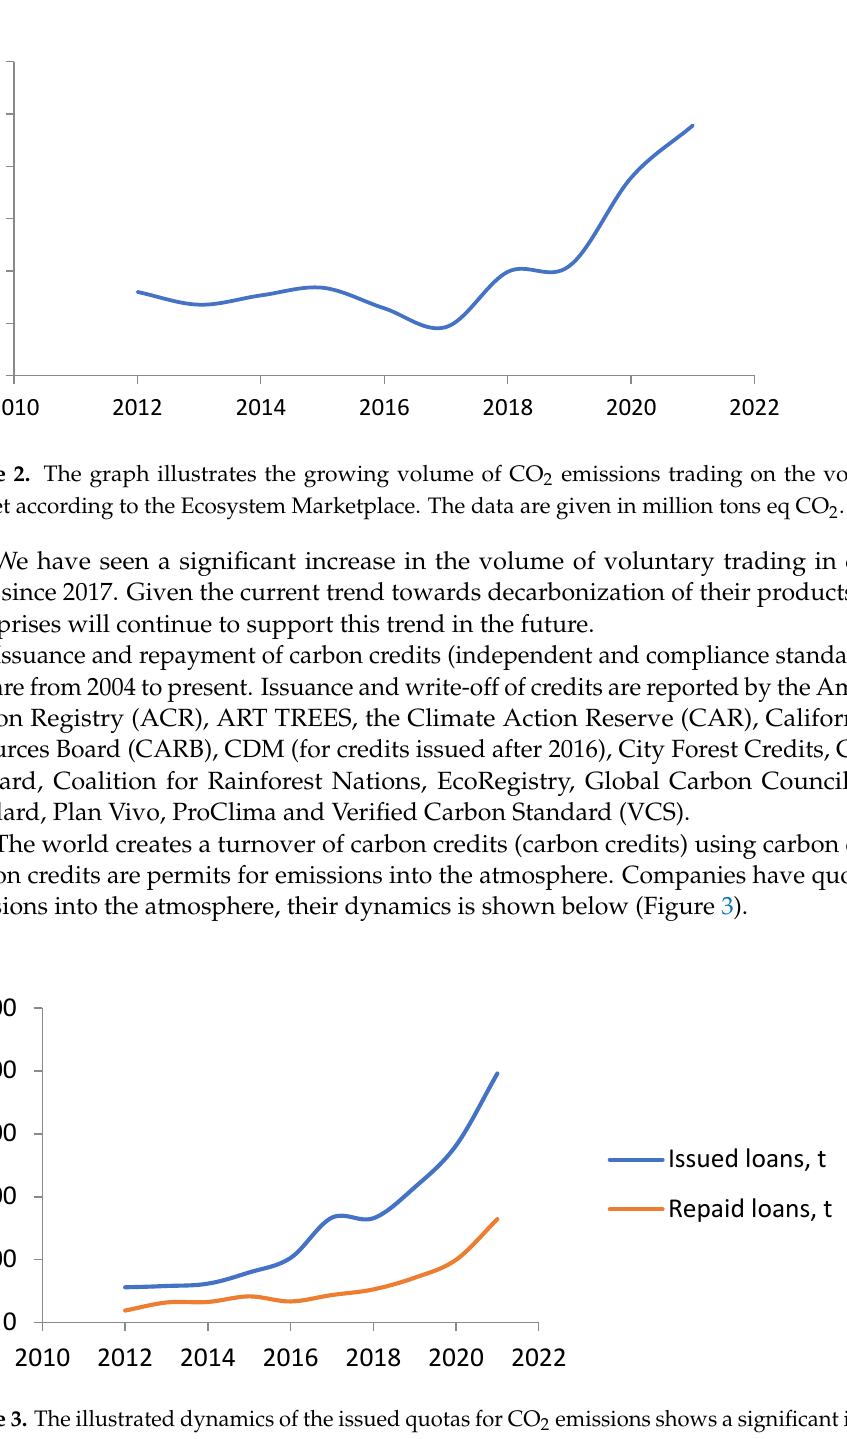
Figure 3. The illustrated dynamics of the issued quotas for CO 2 emissions shows a significant increase in demand for this regulatory instrument. Data according to the Ecosystem Marketplace.